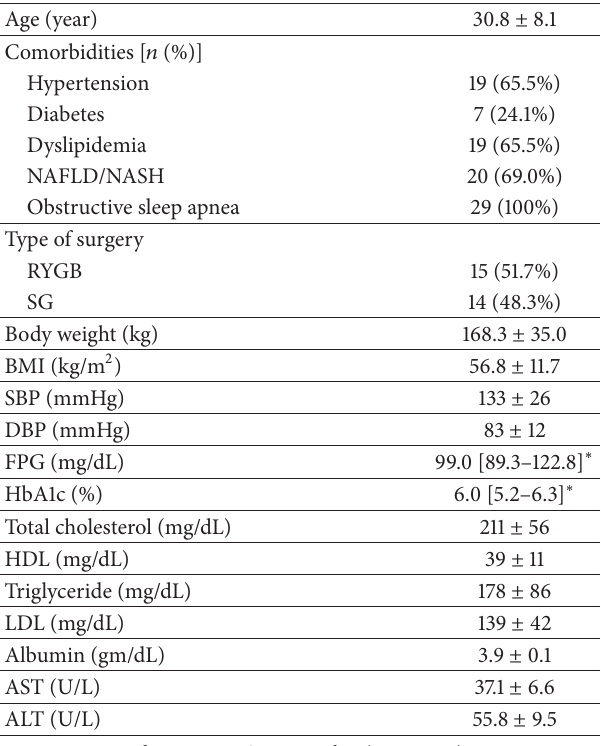
Table 1: Baseline characteristics of participants ( 𝑛 = 29